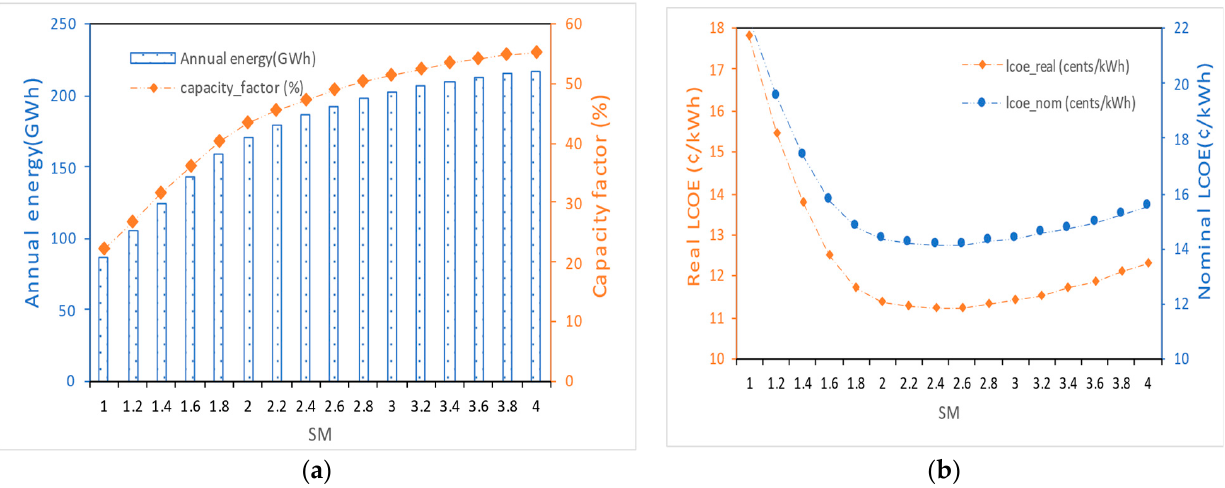
Figure 7. Influence of SM on ( a ) the annual energy produced and the capacity factor and ( b ) LCOEs. Scenarios 6: PTC facility with various thermal storage times